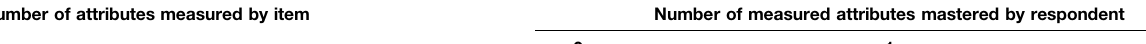
TABLE 3 | Range of item response probabilities for data